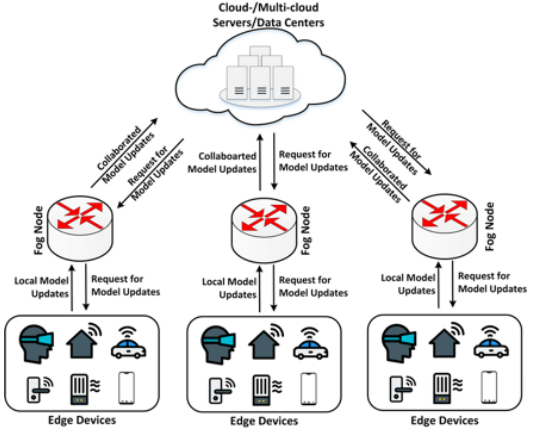
Figure 1. Federal learning system.